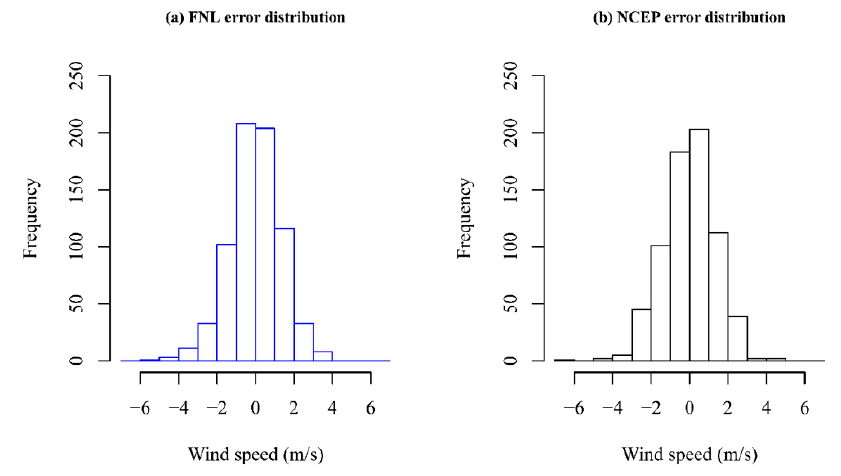
Figure 13. Wind speed error distributions at Piarco for the 10 m height above ground.